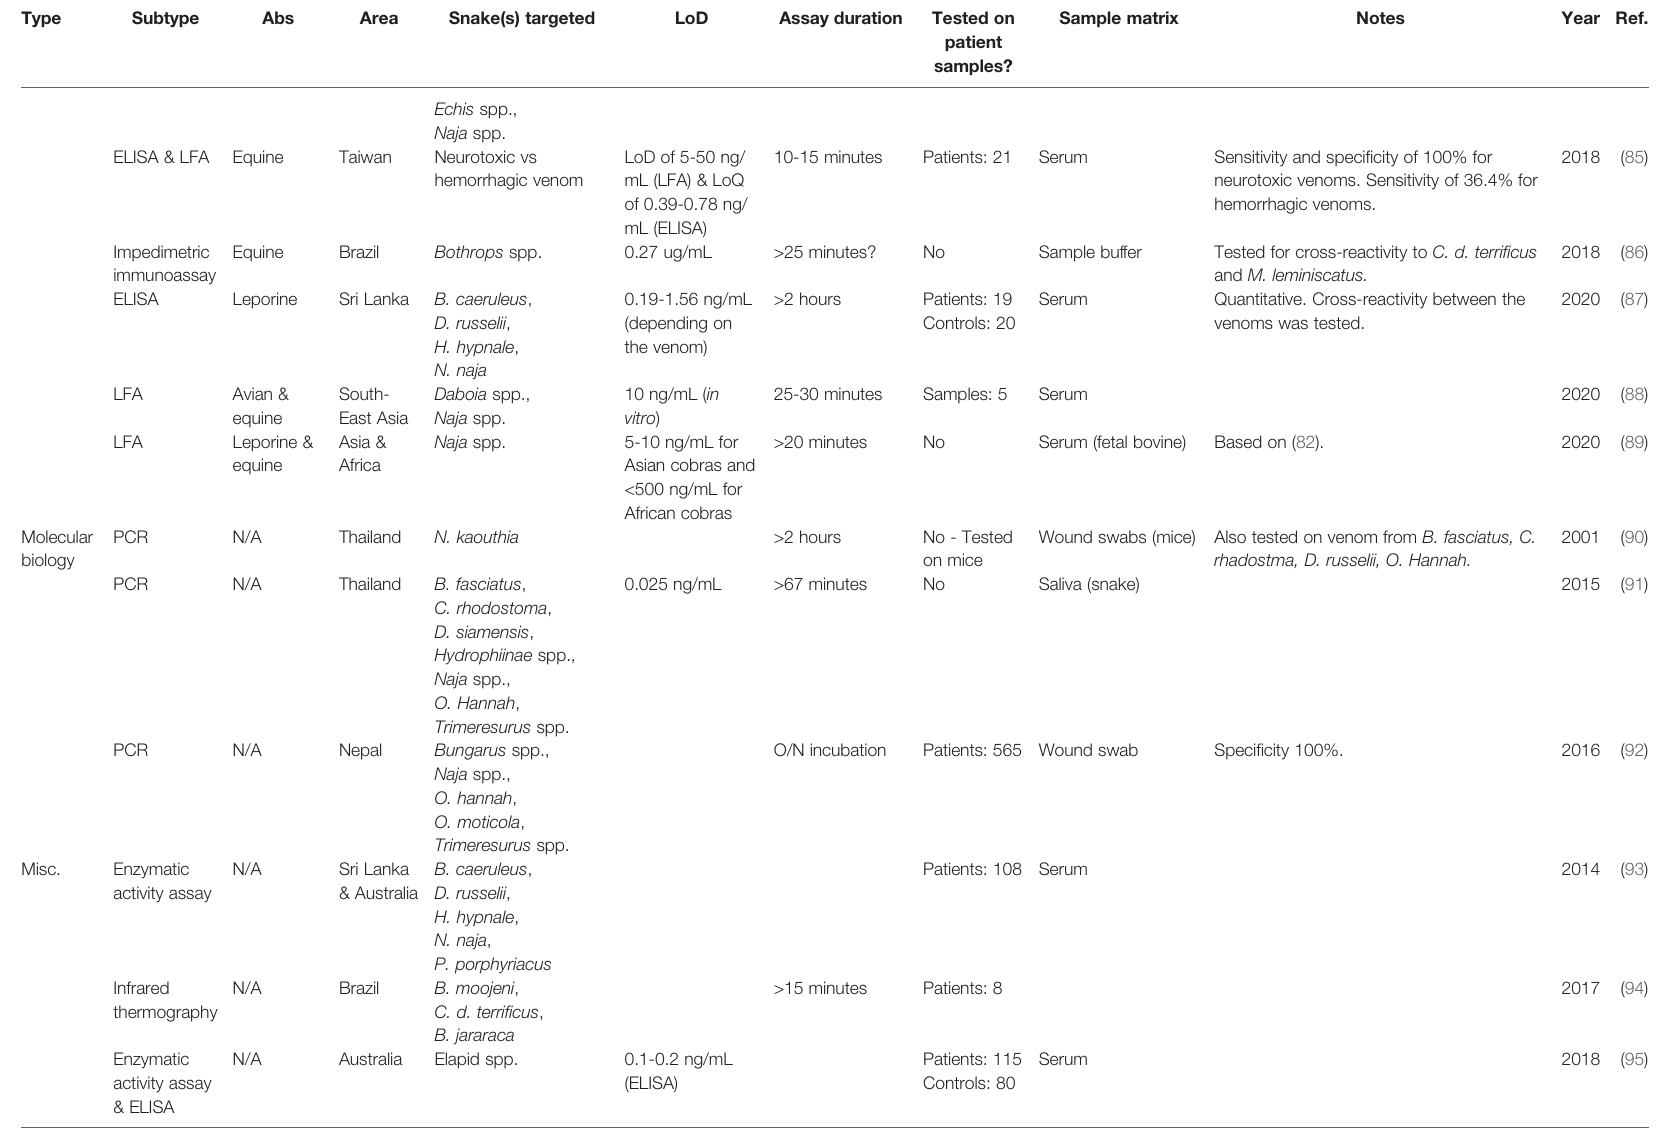
Manystudiesdidnotreportonthedurationofthediagnosticprocedure.Insuchcases,assaydurationwasreportedinthistableas “ >totalincubationtime ” ,e.g. “ >3hours ” foranassaywithanincubationtimeof3hours.Forotherunreported values, the corresponding fi elds were left empty. In some cases, onlythe abstracts of the studies were available to us,and in these cases, values not reported in the abstract have been marked “ ? ” . Studies describing the detection